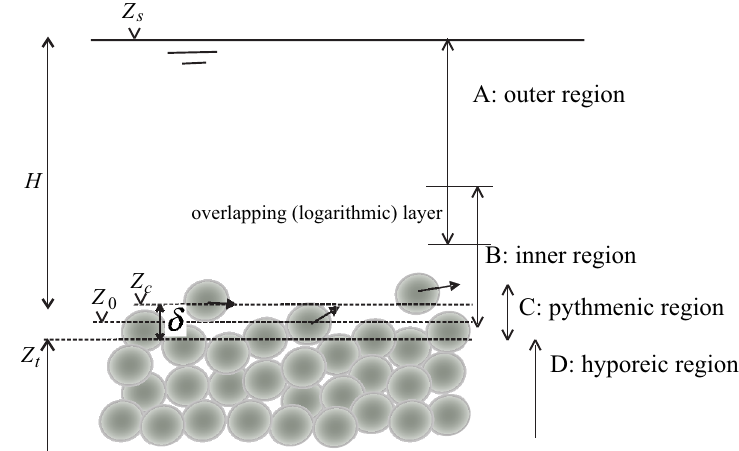
Figure 1. Idealized physical system. Z s is the elevation of the free-surface, Z c and Z t are the space-averaged elevations of the planes of the crests and of the bed troughs, respectively. The bed amplitude is δ = Z c − Z t . All elevations are relative to an arbitrary